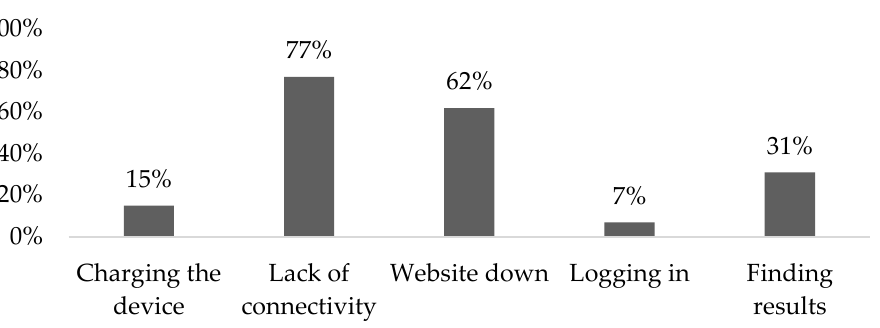
Figure 4. Evaluation of the user survey. The proportion of survey responses was taken once, in 13 system